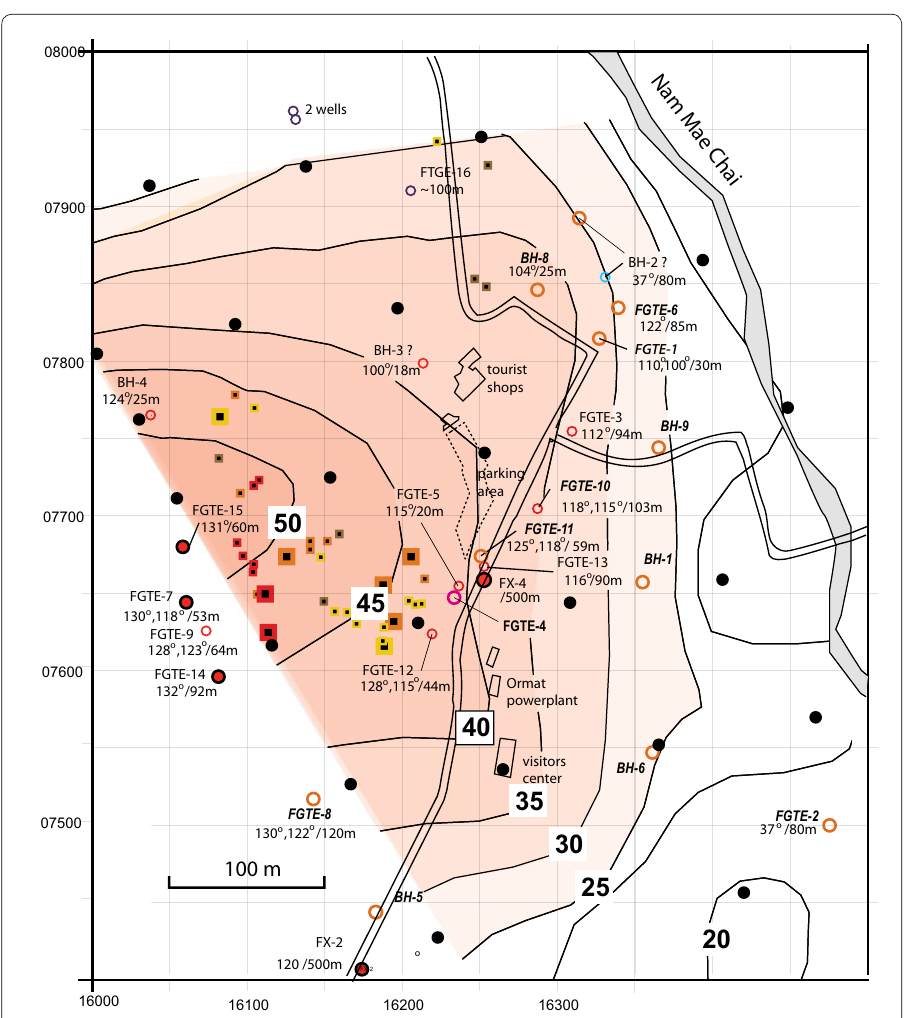
Fig. 24 Map showing 1-m depth temperature survey from Thienprasert and Raksaskulwong (1980) and reprinted with reference to well locations in Coothungkul and Chinapongsanond (1985). Temperature meas- urement point shown by black dots, well, and seep symbols explained in Fig. 23. The 25 °C contour effectively contains all hot wells and seeps and indicates a survey to the southwest may be useful to further